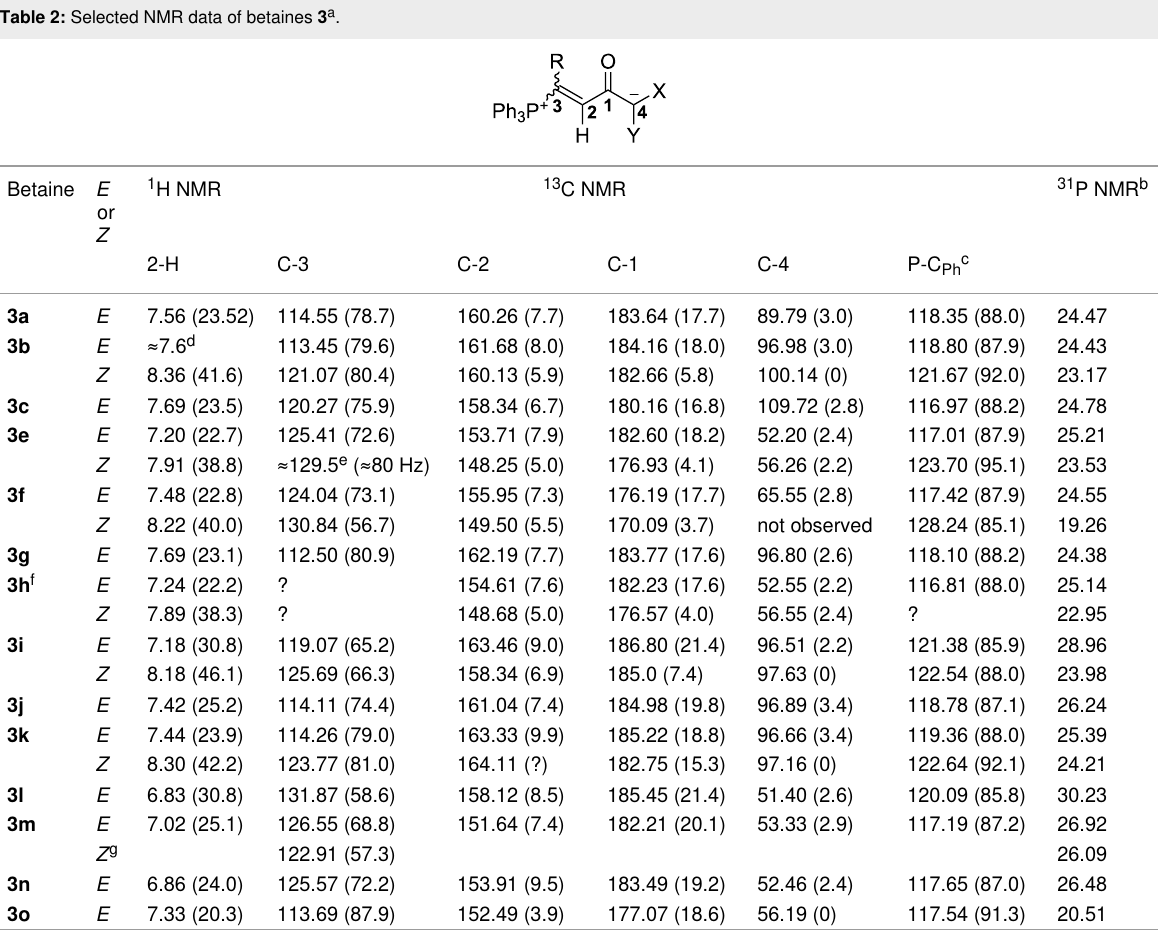
Table 2: Selected NMR data of betaines 3 a